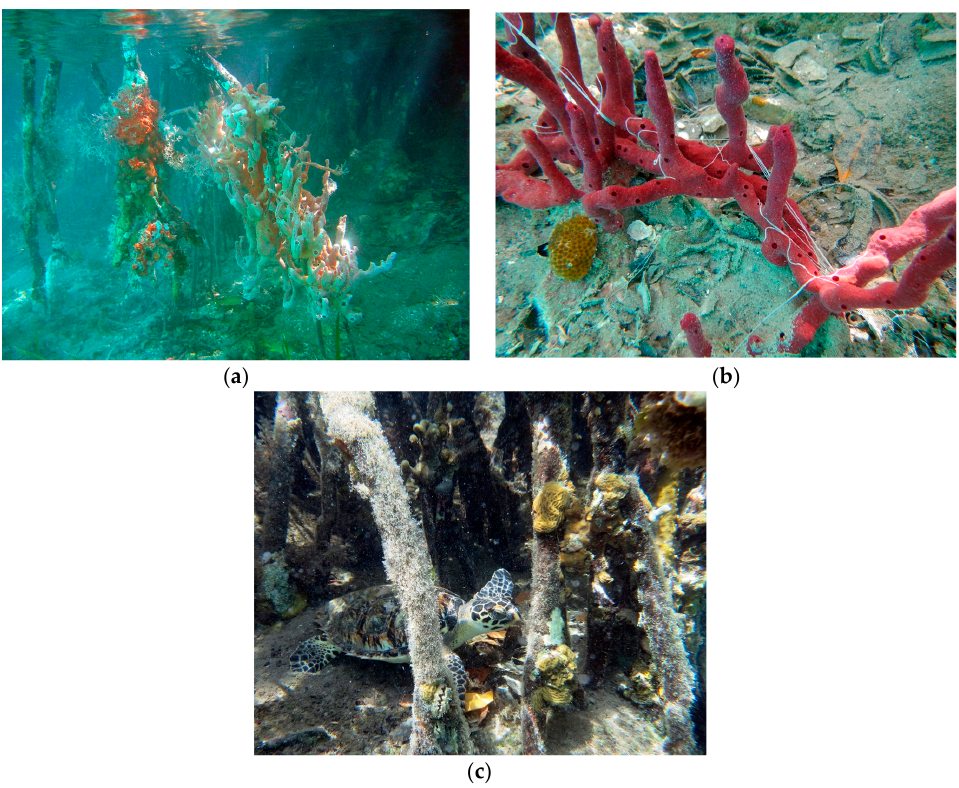
Figure 9. ( a ) Several sponges grow on the prop roots of Red Mangrove trees; ( b ) A red sponge draped with the white tentacles of a Spaghetti Worm ( Eupolymnia crassicornis ); ( c ) A juvenile Hawksbill Sea Turtle ( Eretmochelys imbricata ) among prop roots.